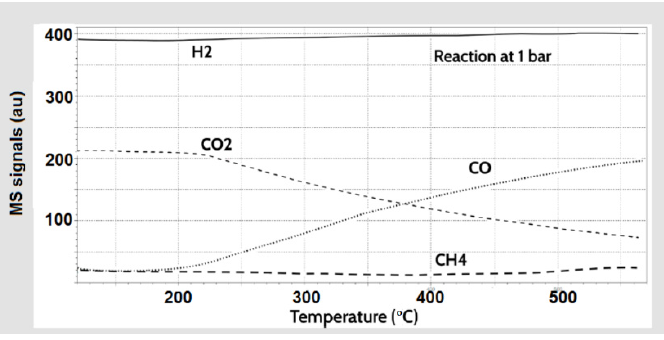
Figure 3. Spectrum of signals at 1 bar.